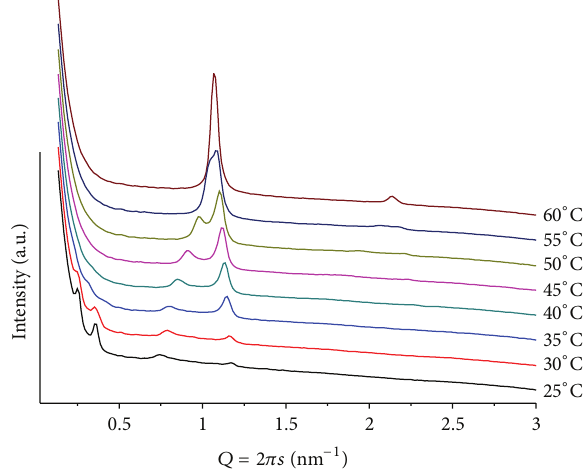
Figure 10: SAXS patterns at different temperatures for POPE/ ANHQ, mr = 50 and pH = 9 .